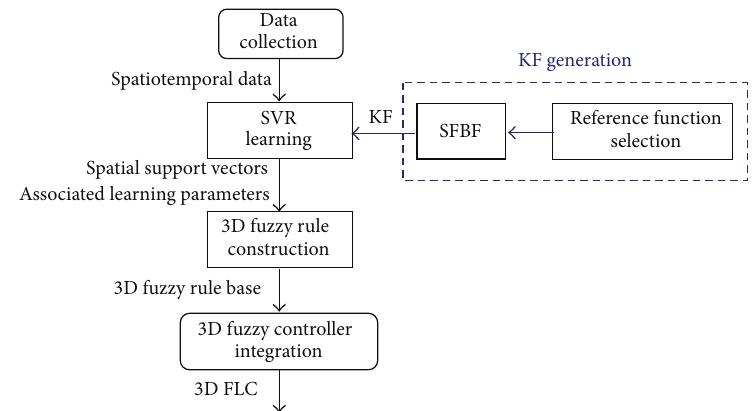
Figure 4: Design scheme of reference function based 3D FLC using SVR